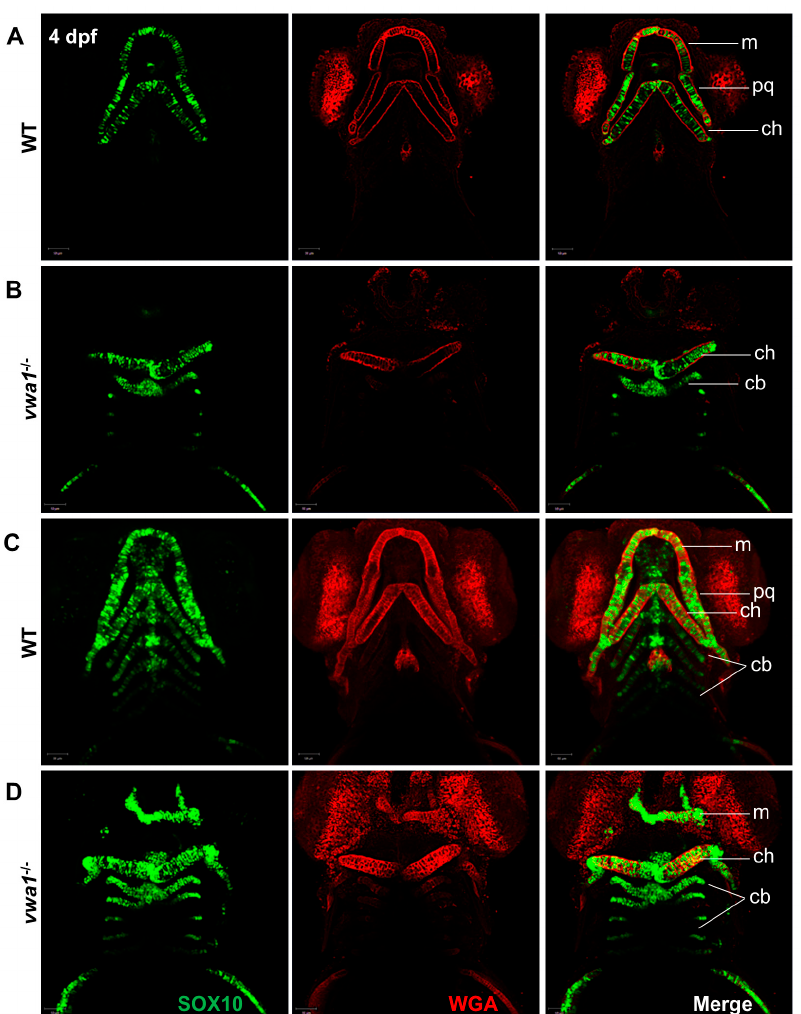
Figure 3. Immunofluorescence assay of WGA and SOX10 reveals a disorganized arrangement of chondrocytes in mutant embryos. ( A , B ) A WT control embryo at 4 dpf, with single-layer images ( A ) showing normal craniofacial cartilage morphogenesis and stacked images ( B ) showing the charac- teristic “stack of pennies” arrangement of cartilage cells in which the slender cartilage cells